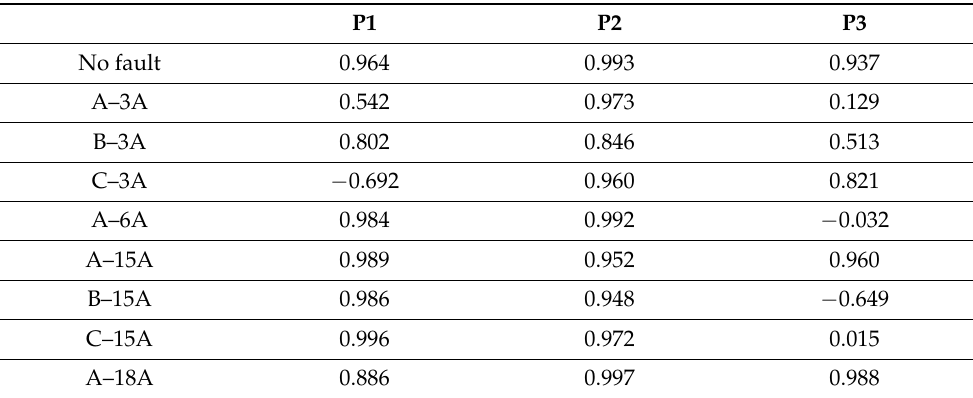
Table 3. Correlation coefficients obtained from three positions in the faulty machine (healthy only for one